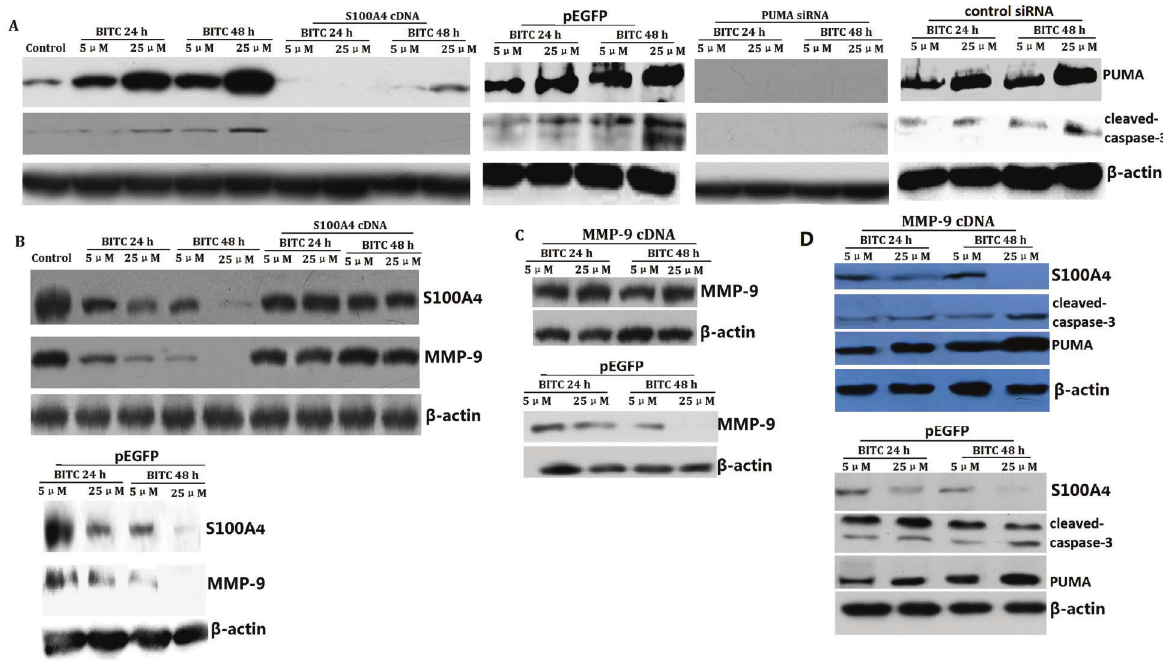
Figure 3. Benzyl isothiocyanate (BITC) inhibited S100A4-dependent p53-upregulated modulator of apoptosis (PUMA) and MMP-9 signals in SCC9 cells in vitro . A , PUMA and cleaved-caspase-3 were detected by western blot assay. B , S100A4 and MMP-9 were detected by western blot assay. C , MMP-9 was detected by western blot assay. D, S100A4, cleaved-caspase-3, and PUMA were detected by western blot assay.